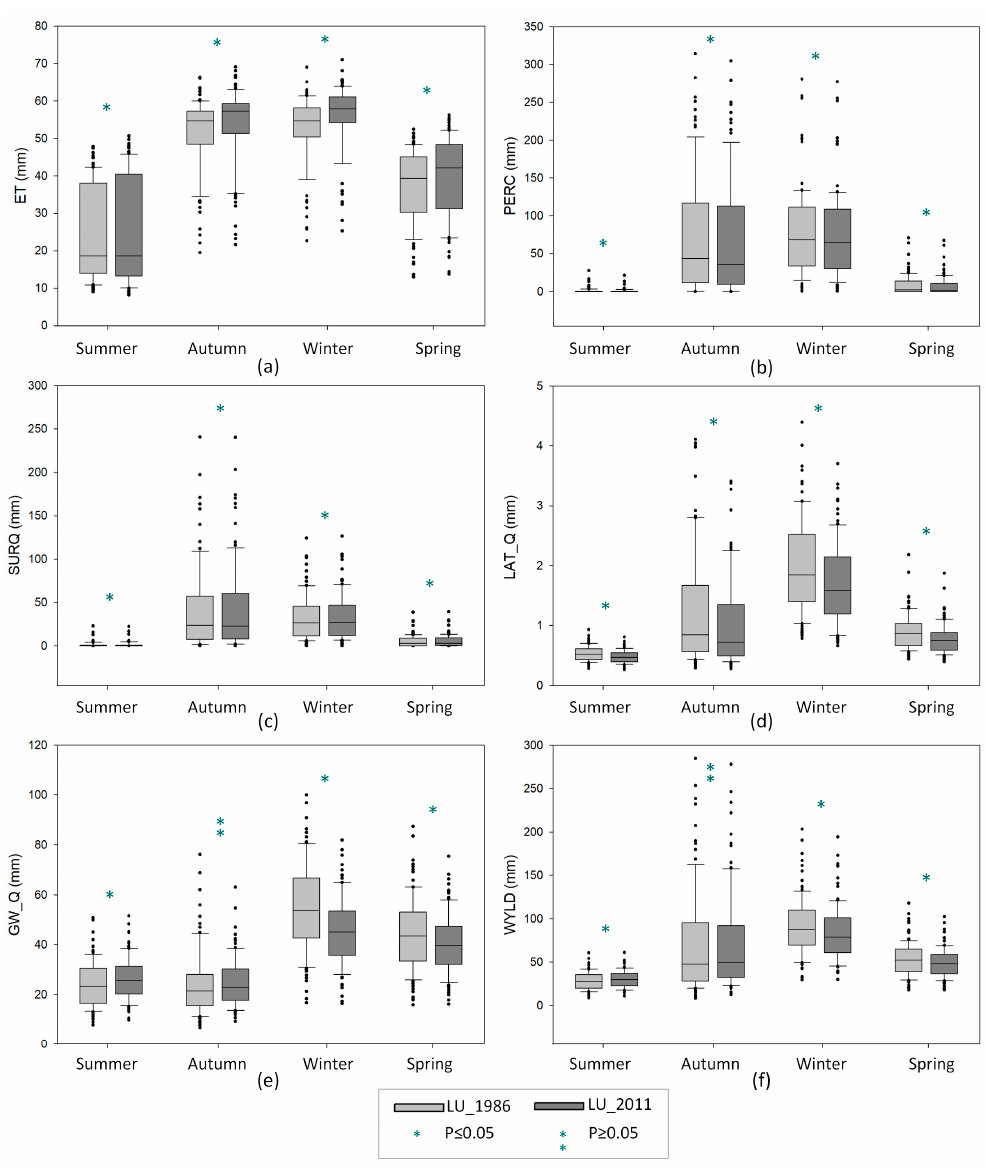
Figure 6. Seasonal average: summer (January, February, March) ( a ), autumn (April, May, June) ( b ), winter (July, August, September) ( c ), and spring (October, November, December) ( d ) of the